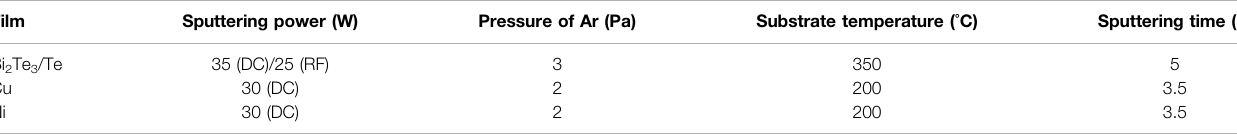
TABLE 2 | Sputtering parameters of the main fi lms (DC: direct current; RF: radio